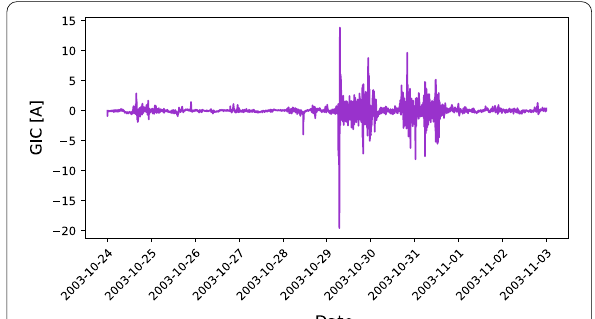
Fig. 5 Modelled GIC in substation Přeštice during Halloween storms. The plot indicates the current flowing through the substation’s grounding point. Positive values indicate the current flowing from the network to the ground